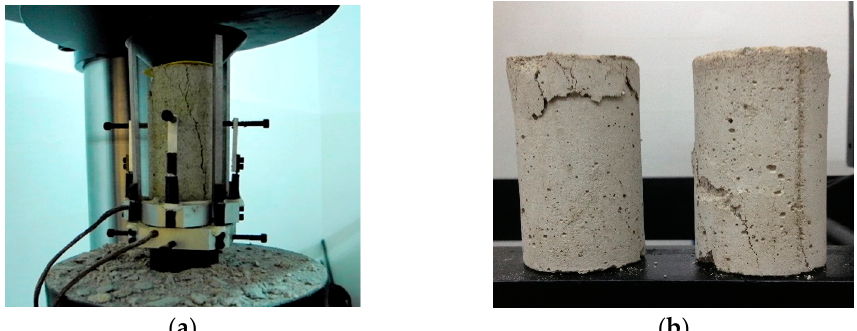
Figure 2. Sample of similar material.